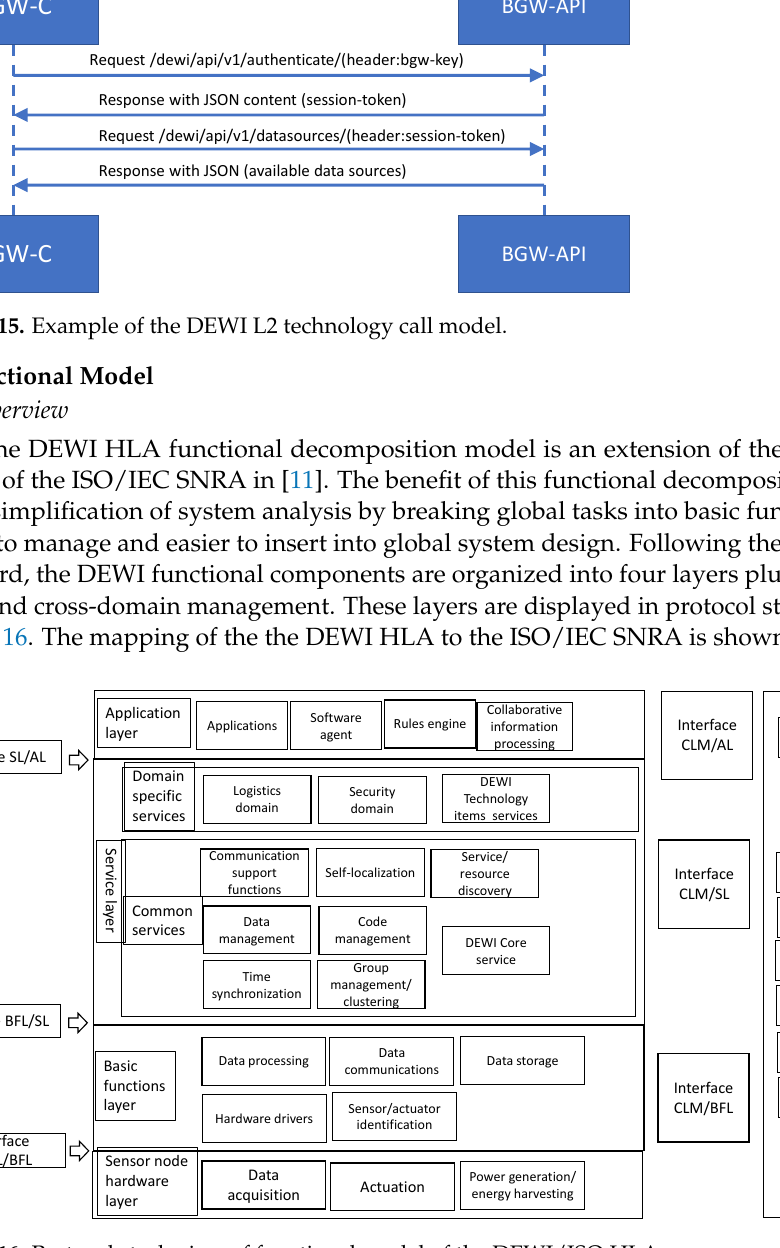
Figure 16. Protocol stack view of functional model of the DEWI/ISO